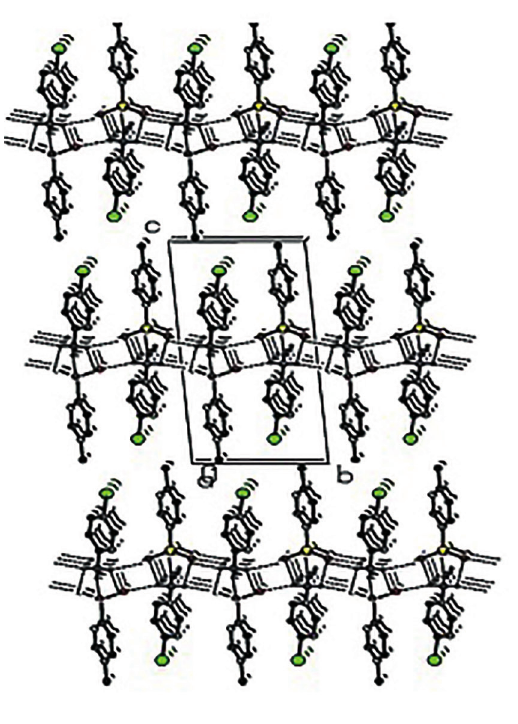
Figure 3: The crystal packing of the 4BPTS.